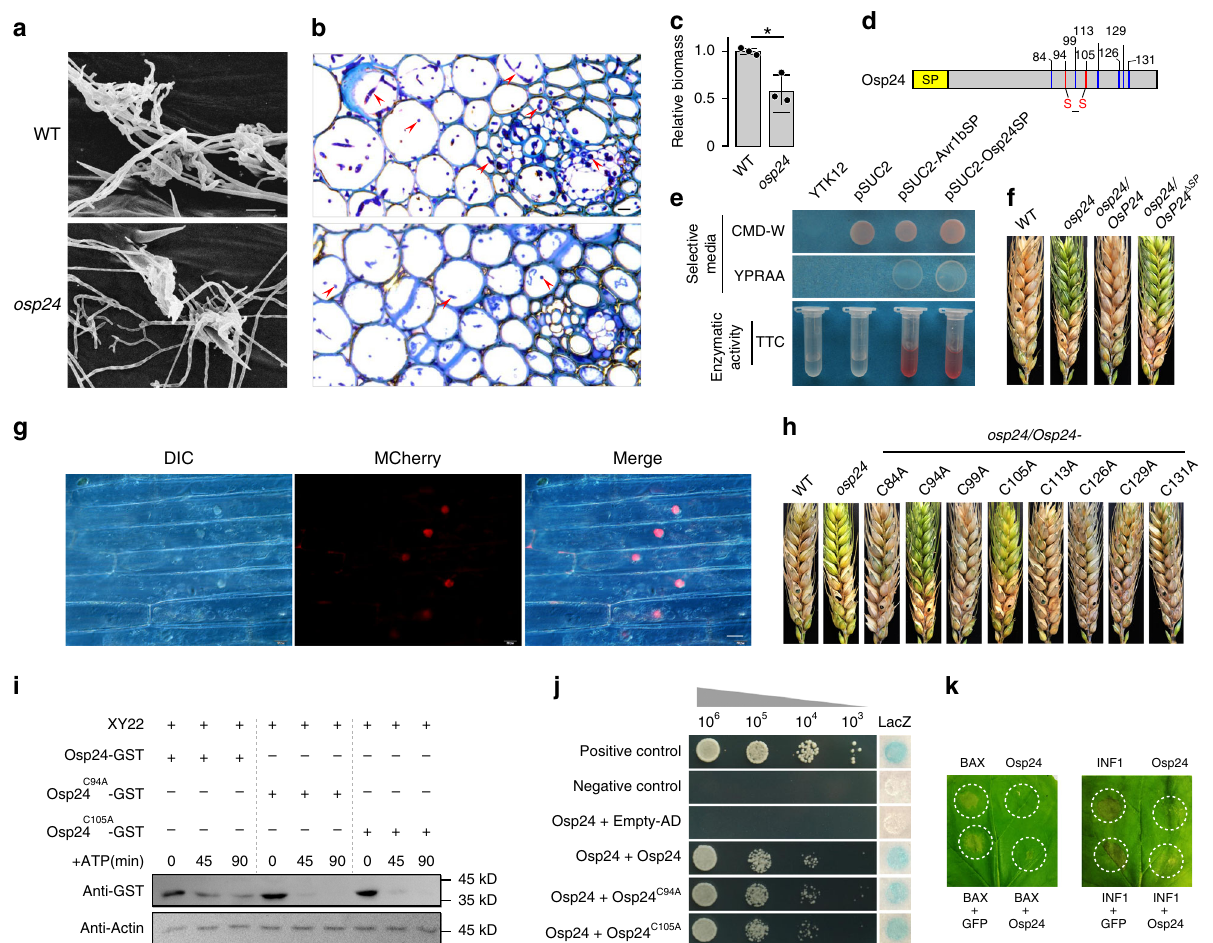
Fig. 2 Functions of Osp24 and its signal peptide and cysteine residues. a Infection cushions formed by the wild-type strain PH-1 (WT) and osp24 deletion mutant on wheat lemma at 2 dpi were examined by SEM under ×800 ampli fi cation. Scale bar, 10 µ m. b . Thick sections of infected wheat heads were examined for invasive hyphae (red arrowheads) in the rachis tissues at 5 dpi. Scale bar, 20 µ m. c Relative biomass of F. graminearum in infected wheat heads at 5 dpi was determined by qPCR. Mean and standard deviation were estimated with data from three ( n = 3) independent biological replicates (marked as black dots on the bar). The asterisk * indicates signi fi cant differences ( P = 0.05) based on Bootstrap analysis. d The positions of eight cysteine residues in Osp24 and the predicted intra-molecular disul fi de bond between C94 and C105. SP, signal peptide. e The yeast suc2 mutant YTK12 and its transformants expressing the empty vector pSUC2 or vectors with the signal peptide from Osp24 and Avr1 (positive control) were assayed for growth on CMD-W or YPRAA plates and invertase activity in TTC medium. f Representative images of wheat heads infected with PH-1, osp24 mutant, and the osp24 / OSP24 and osp24 / OSP24 Δ SP transformants were photographed at 14 dpi. g Wheat coleoptiles were infected with PH-1 expressing the Osp24: mCherry:NLS construct and examined for mCherry signals in plant cells. Scale bar, 20 µ m. h Representative images of wheat heads infected with PH-1, osp24 mutant, and transformants of osp24 expressing OSP24 mutant alleles carrying the indicated C-to-A mutations were photographed at 14 dpi. i Western blots of mixtures of equal amounts of total proteins isolated from wheat heads of cultivar Xiaoyan 22 (XY22) and recombinant Osp24-GST, Osp24 C94A -GST, or Osp24 C105A – GST proteins incubated for the indicated times after the addition of 10 mM ATP were detected with an anti-GST antibody. Detection with an anti-actin antibody was used as a loading control. j Different concentrations (cells/ml) of yeast transformants expressing the indicated bait and prey constructs were assayed for growth on SD-Trp-Leu-His plates and LacZ activity. k Transient expression of Osp24 suppressed programmed cell death triggered by BAX or INF1. At the indicated spots, N. benthamiana leaves were in fi ltrated with Agrobacterium cells expressing GFP/ BAX/INF1 alone or in fi ltrated with BAX/INF1-expressing cells at 18 h after in fi ltration with GFP or Osp24 fi rst. Representative leaves were photographed 5 days after in fi Osp24 (Fig. 2d) into the vector pSUC2 40 and transformed into the yeast suc2 mutant 41 . The resulting SP- SUC2 transformants were able to grow on YPRAA agar and had secreted invertase activity (Fig. 2e), indicating that the SP of Osp24 is functional in yeast. To test its function in F. graminearum , we then generated the OSP24 and OSP24 Δ SP constructs 42,43 and transformed them into the osp24 mutant. The resulting osp24 / OSP24 transformants were normal in virulence. However, the osp24 / OSP24 Δ SP transformants